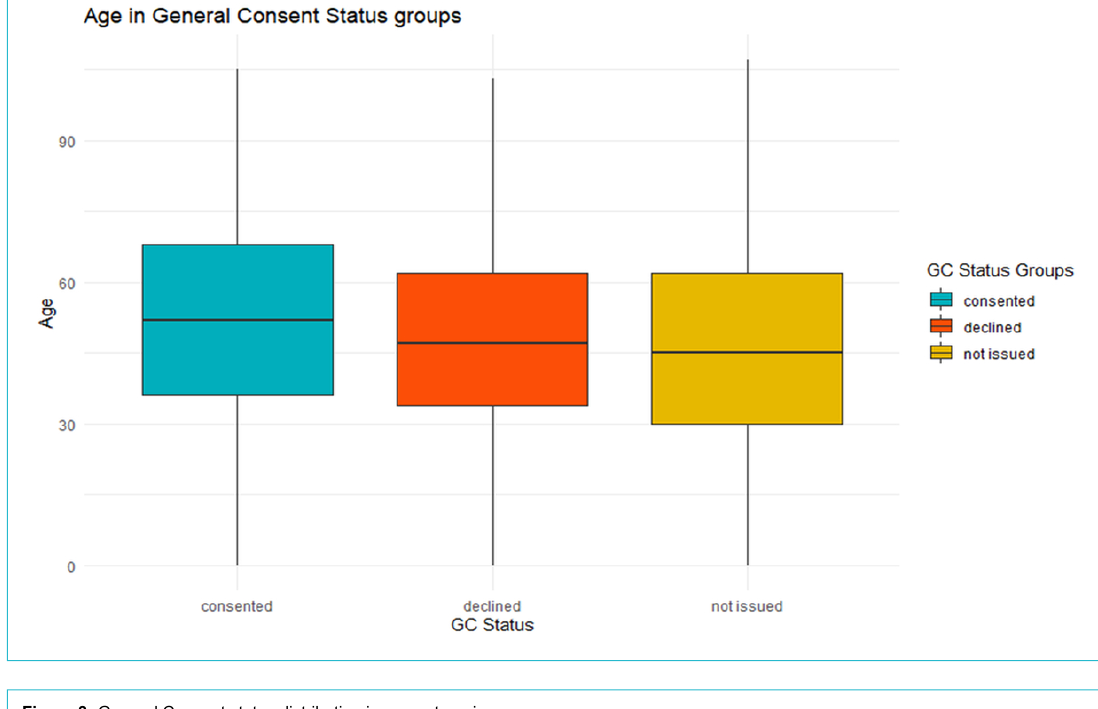
Figure 3: General Consent status distribution in age